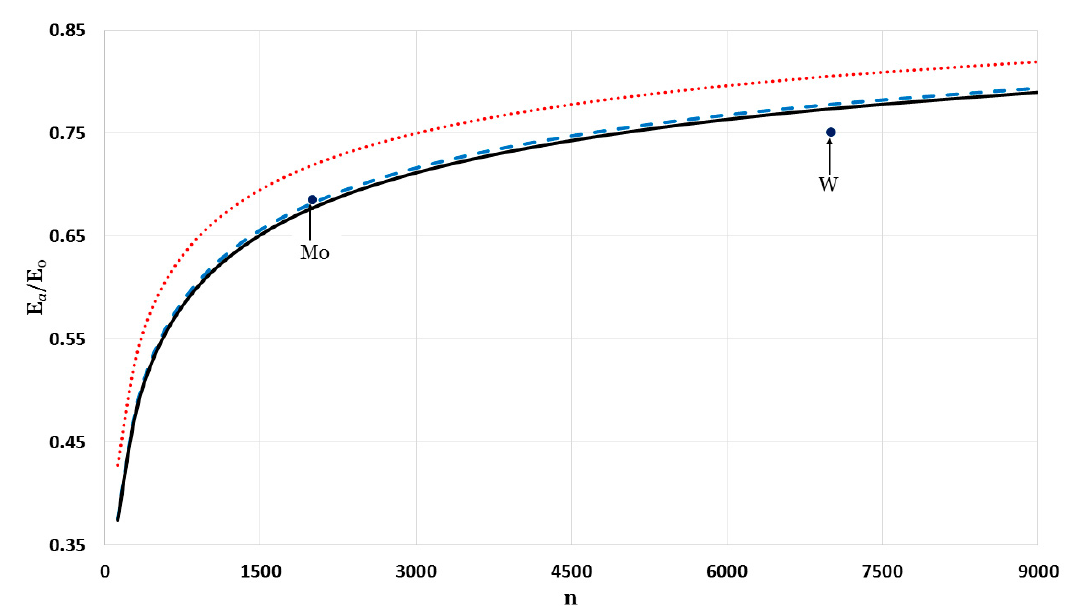
Figure 16. The variation of the relative cohesive energy as function of the number of atoms (where m = 4 and α = 1.95) for di ff erent cubic structures of nanoparticles: A body-centered cubic structure (black solid line), a face-centered cubic structure (blue dashed line), and a simple cubic structure (the red dotted line). The experimental values [23,24] are denoted by dark blue circles.